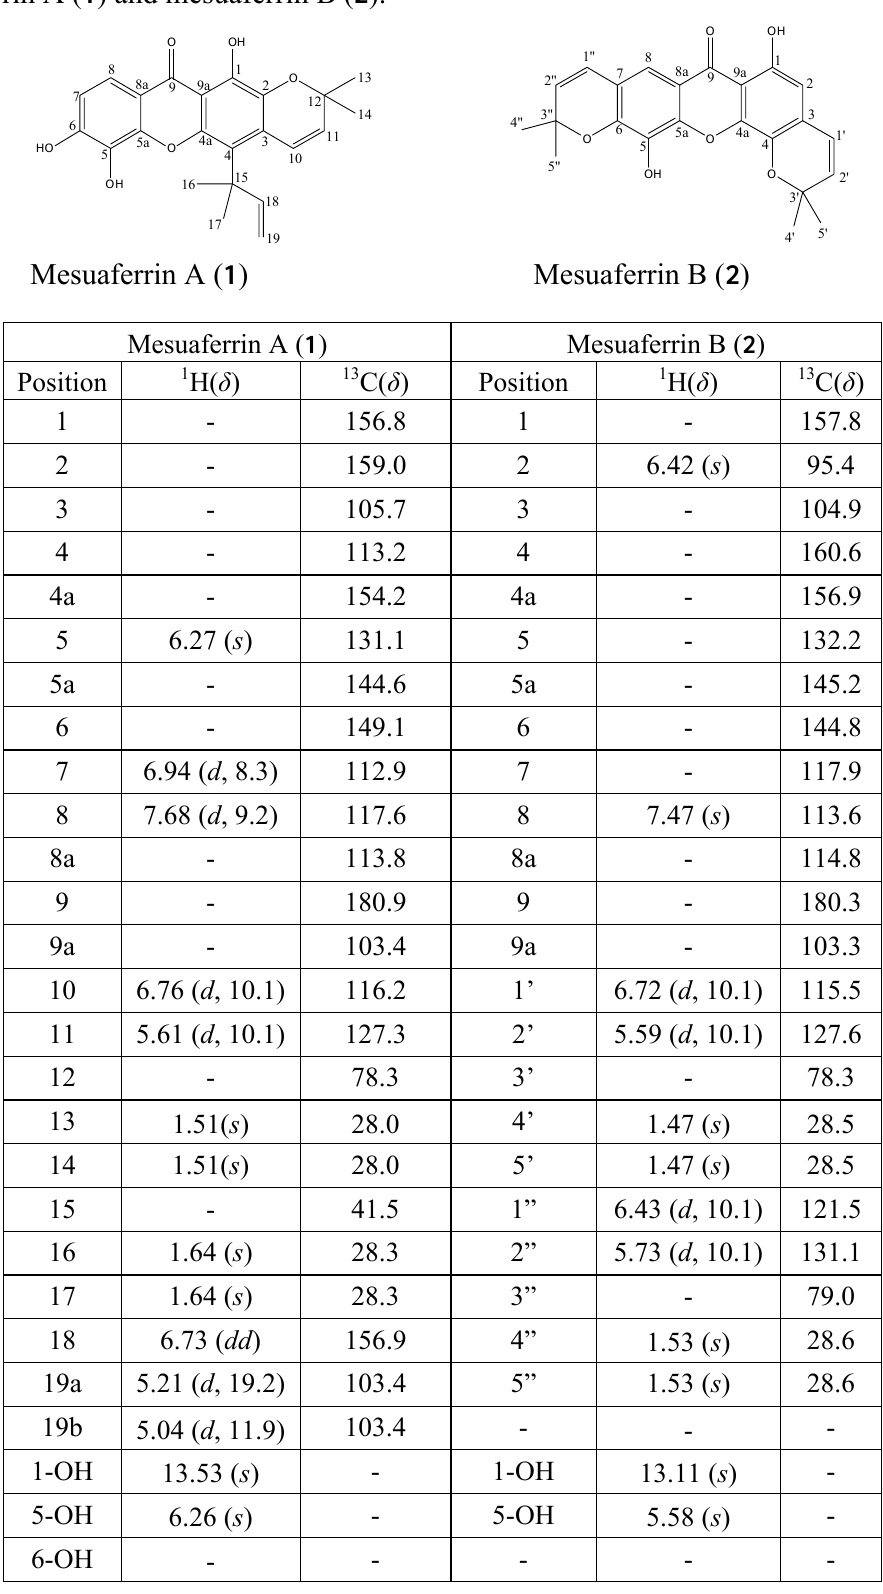
Table 1. 1 H-NMR (500 MHz, CDCl mesuaferrin A ( 1 ) and mesuaferrin B ( 2